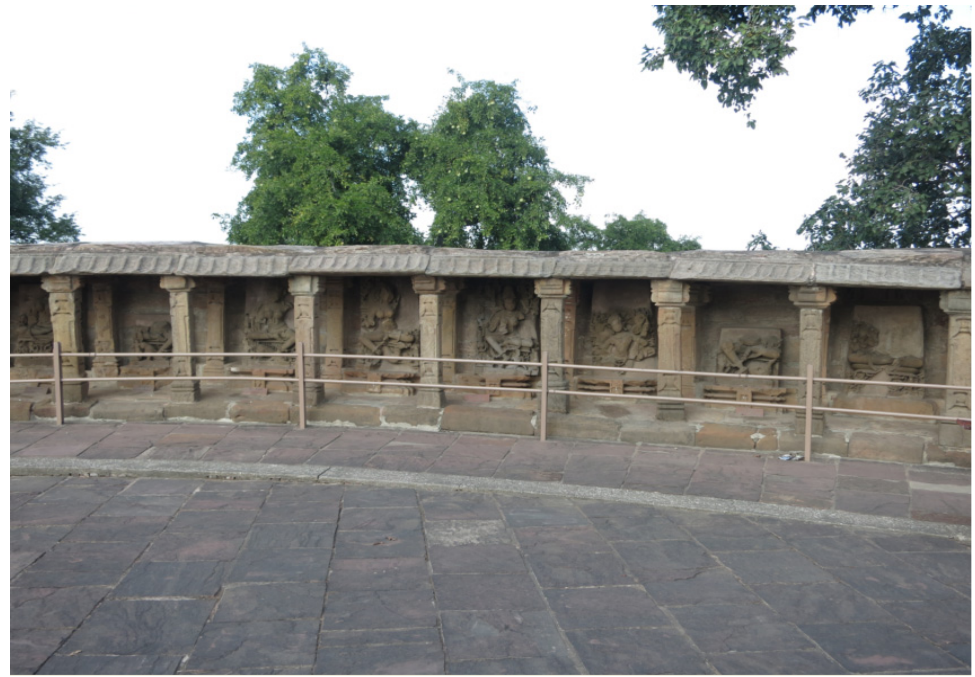
Figure 4. Yogini temple, Bheraghat, Madhya Pradesh, ca. late 10th–early 11th century. Photograph by Katherine E. Kasdorf.